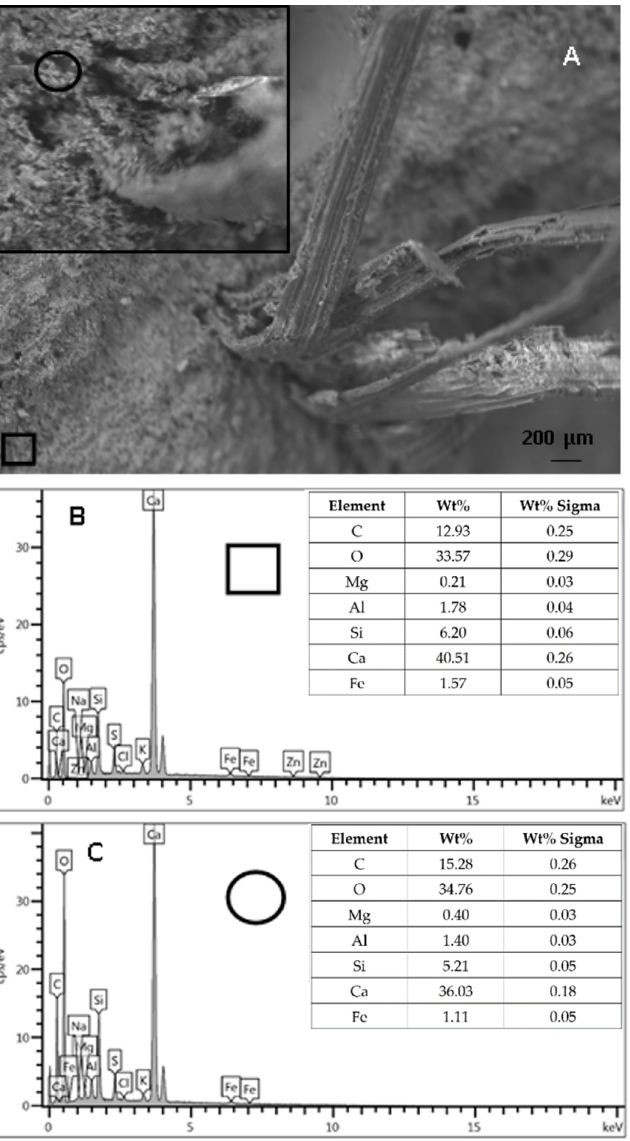
Figure 13. ( A ) SEM image of the cement/straw system with square spot showing the cement paste far from straw, in the inset: magnification of the cement paste close to straw and represented by circular spot. ( B ) EDX spectrum relative to the square spot (far from straw). ( C ) EDX spectrum relative to the circular spot (close to straw).